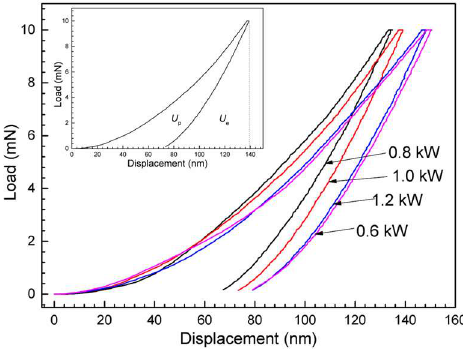
Figure 7. Representative load versus displacement curves of the four CrAlSiN coatings deposited under di ff erent Al sputtering power.